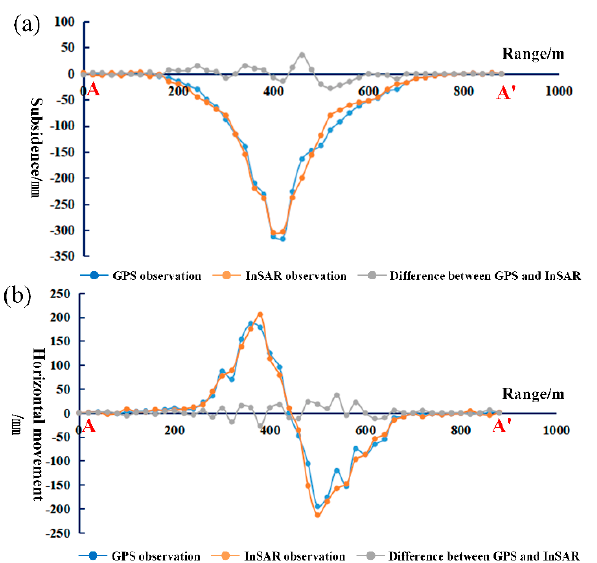
Figure 11. Comparison between the in-situ GPS measurements (orange line) and the displacements estimated by the proposed method (blue line) over the field observation points (i.e., profile AA’ in Figure 6) in the vertical ( a ) and horizontal ( b ) directions. The gray line is the difference between the GPS and InSAR measurements at the monitoring points.